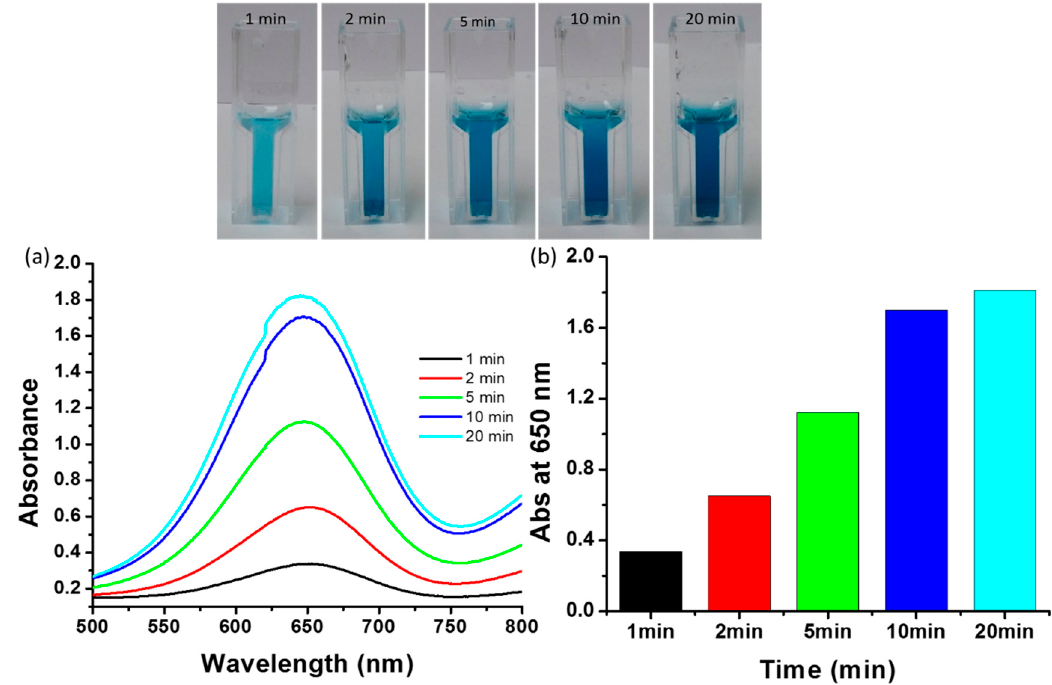
Figure 6. Effect of incubation time. ( a ) Absorbance spectra at various incubation times and (inset) cuvettes demonstrating the effect of incubation time on the color development. ( b ) Absorbance at 650 nm with the function of time.